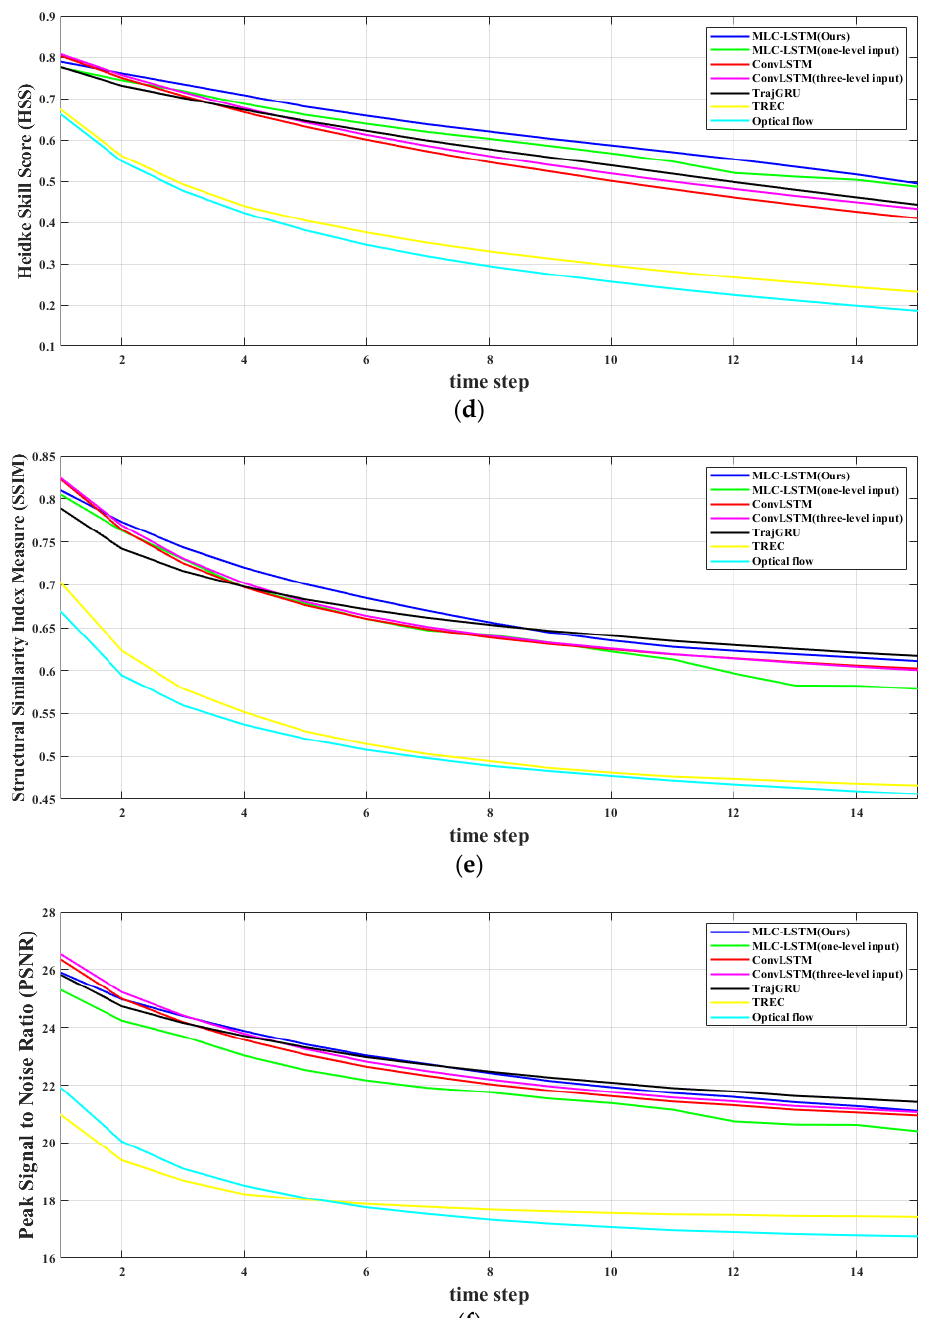
Figure 10. Frame-wise comparison results of seven model on six metrics. ( a ) Probability of detection (POD) changing curve; ( b ) false alarm rate (FAR) changing curve; ( c ) critical success index (CSI) changing curve; ( d ) Heidke skill score (HSS) changing curve; ( e ) structural similarity index measure (SSIM) changing curve; ( f ) peak signal to noise ratio (PSNR) changing curve.